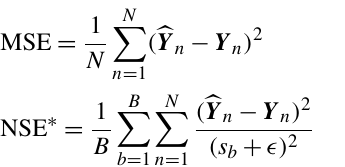
Median slope Static Median drainage density